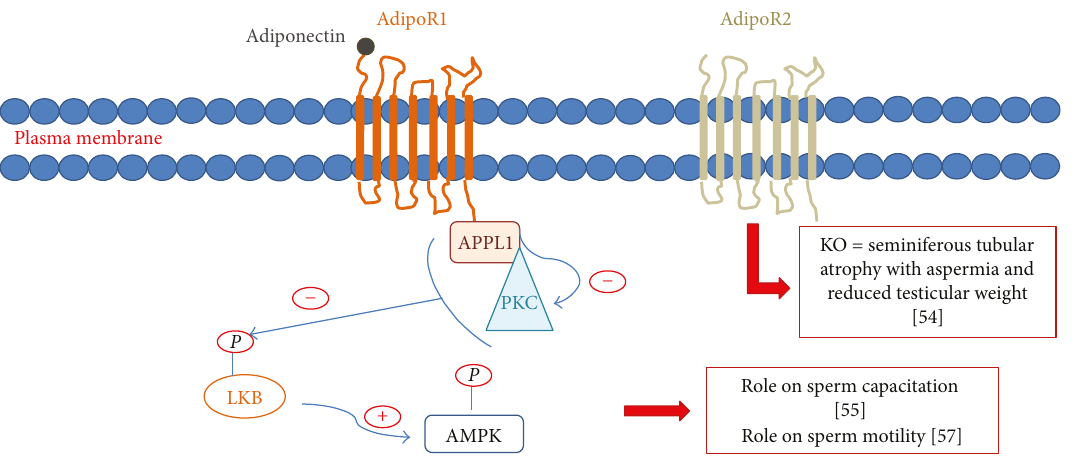
Figure 2: Adiponectin receptors and its possible interactions to